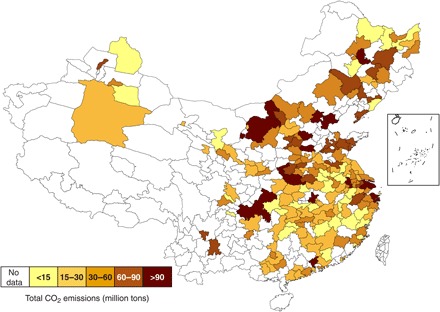
Total CO2 emissions of 182 Chinese cities.